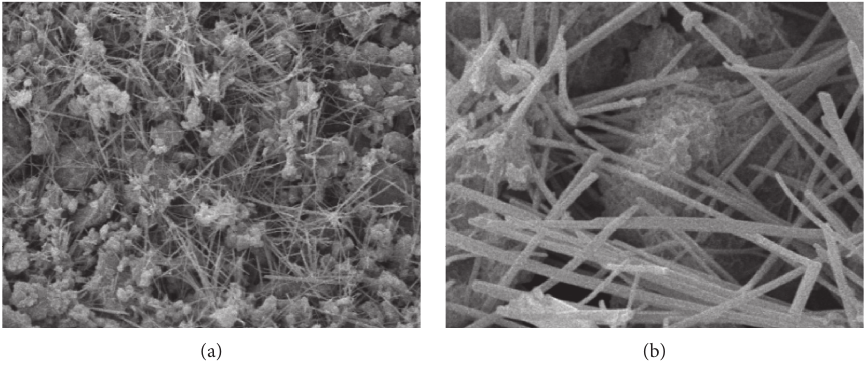
Figure 11: SEM diagram of 28 days of specimen maintenance: (a) × 500; (b) ×